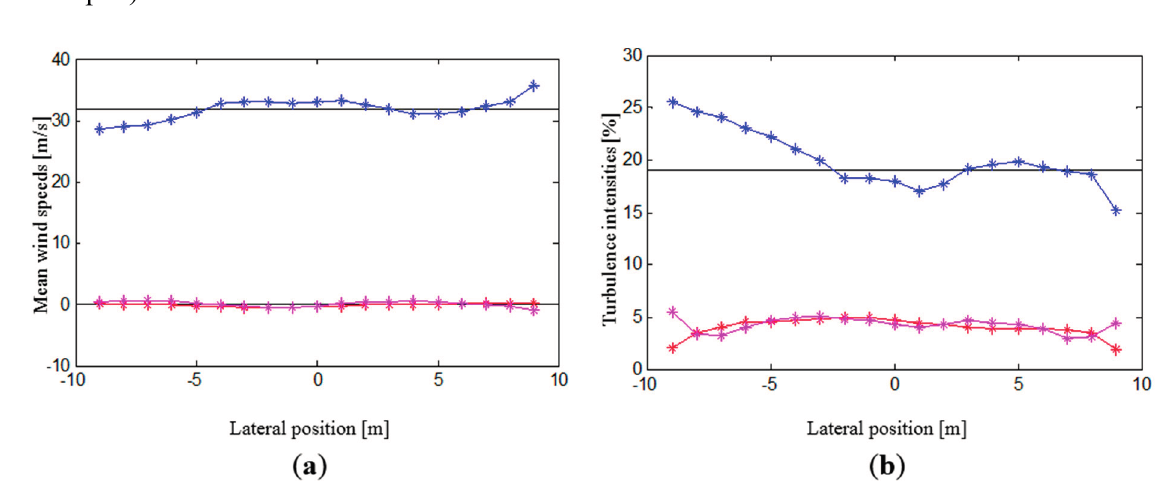
= 5 cm and a based velocity equal to (cid:2868)